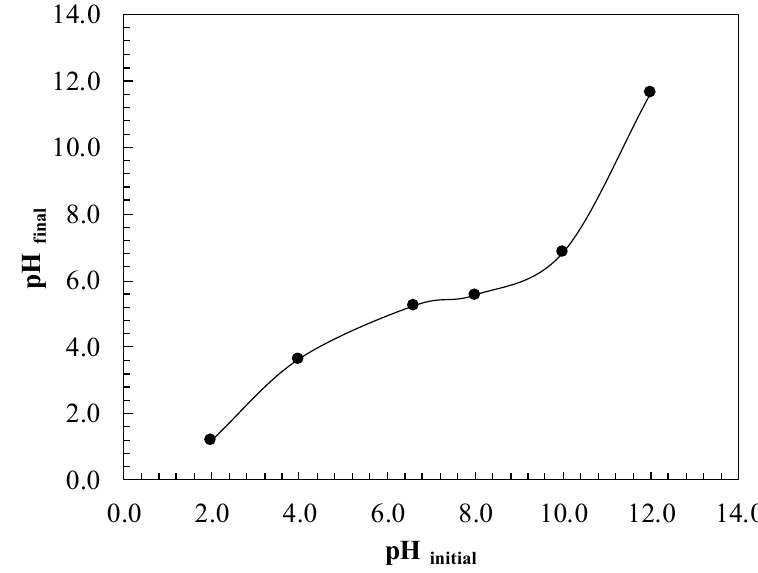
Figure 2. Isoelectric point of TiO 2 P25 catalyst determined by acid-base titration method.